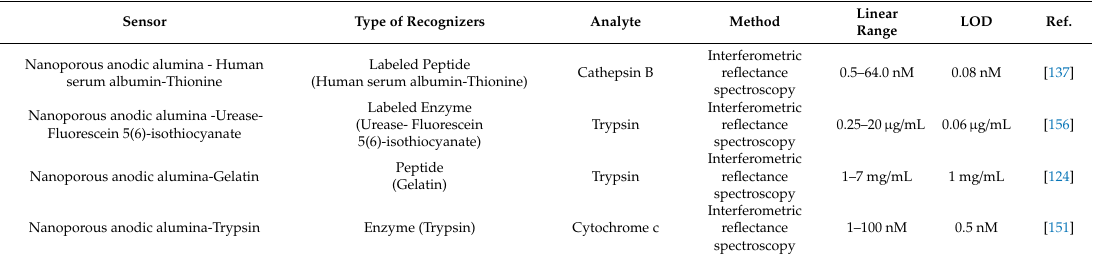
Table 1. The analytical performance of the optical biosensors and sensors by using NAA. Sensor Type of Recognizers